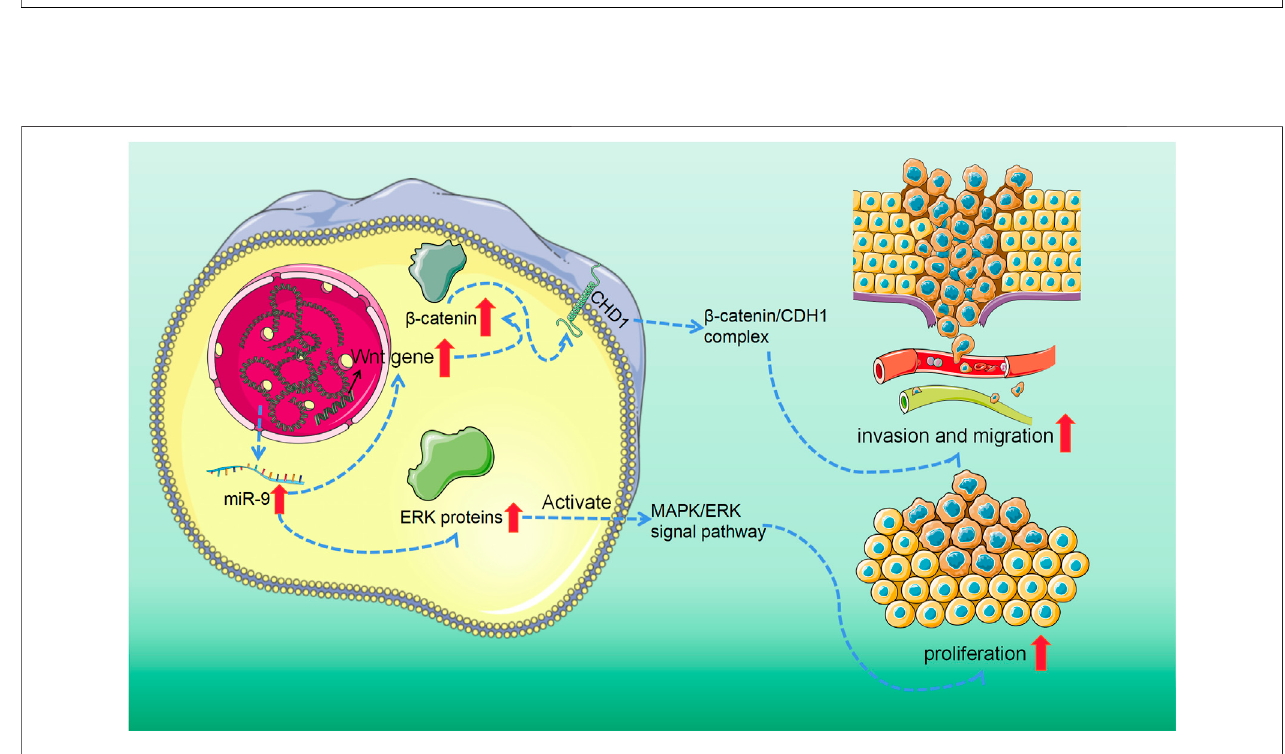
FIGURE 2 | With the occurrence of chromosome 18 and X chromosome ectopic, synovial sarcoma cells produce synovial sarcoma (SS)18-SSX fusion oncoprotein. Then, these fusion oncoproteins promoted the expression of miR-17. Afterward, miR-17 binds to p21 mRNA and inhibits its normal function. Since in normalfunctioning,p21caninhibitcell ’ sG1 ⁄ StransitionwithCyclin-CDK2andCyclin-CDK4complexesasitstargetsandthenful fi llitstumorsuppressorrole.Therefore, miR-17 fi nally leads to the invasive growth of synovial sarcoma cells by posttranscriptional suppression of p21.